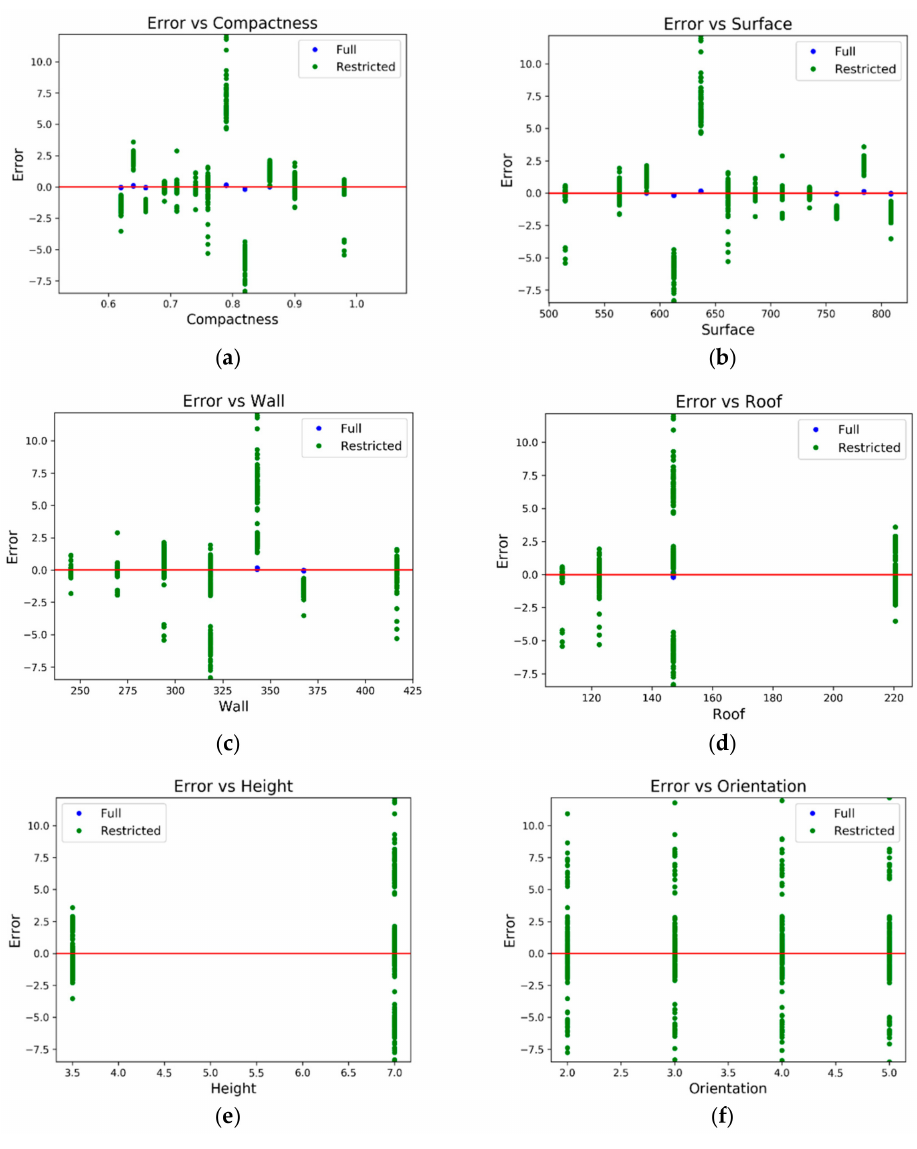
Figure 5. Results of the heating load problem for the full and restricted models with the parameter selection h = ω = 0.033. ( a ) Estimated vs experimental values; ( b ) Estimated vs experimental values